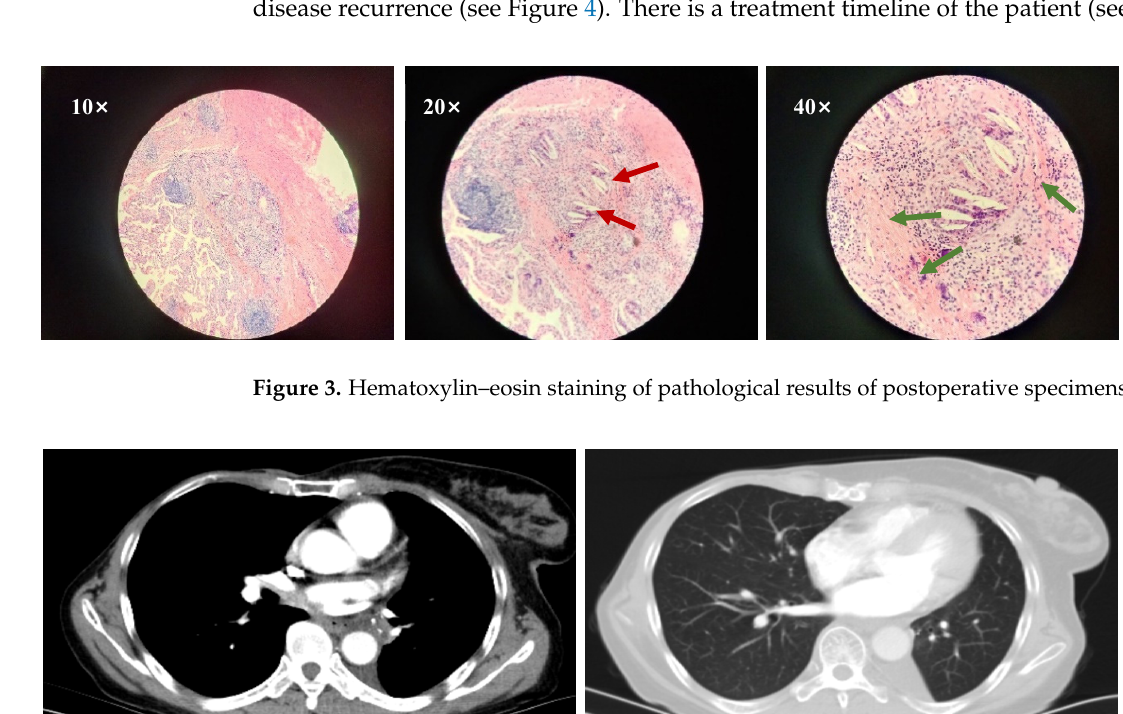
4 Figure 2. ( a ) indicates the decreasing trend of the NLR; ( b ) indicates a decrease in the PLR; ( c ) indi- cates a higher level of serum LDH at the time of initial diagnosis, which decreased after treatment; ( d ) indicates a significant fluctuation in the LMR. The combination therapy was well tolerated and the patient experienced grade 2 myelosuppression and grade 1 thyroid dysfunction, which were both controlled via symptomatic interventions. Adverse events were graded based on the common terminol- ogy criteria for adverse events (CTCAE-version 5.0). Considering the potential cardiotox- icity due to adjuvant chemotherapy and anti-HER2 therapy following radical breast can- cer surgery, we focused on evaluating the patient’s electrocardiography (ECG), myocar- dial enzyme spectrum, and left ventricular ejection fraction (LVEF) and other related in- dicators. No cardiac adverse effects have been observed in the patient to date. The patient underwent a thoracoscopic left lower lobectomy with lymph node dissection on 10 No- vember 2021; R0 resection was achieved with negative margins. No residual cancer cells were observed in the resected pulmonary tissue and lymph nodes during the postopera-